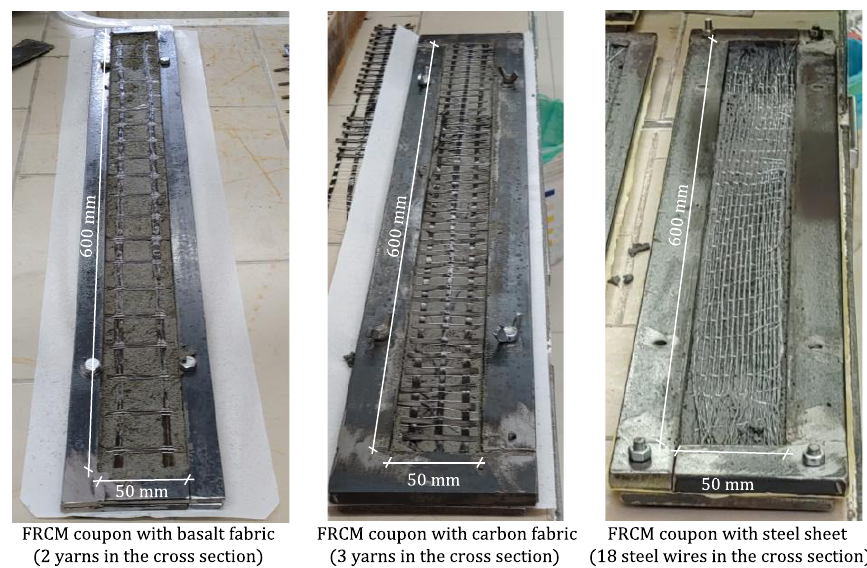
Figure 4. Preparation of FRCM coupons with basalt, carbon, and steel fibers.